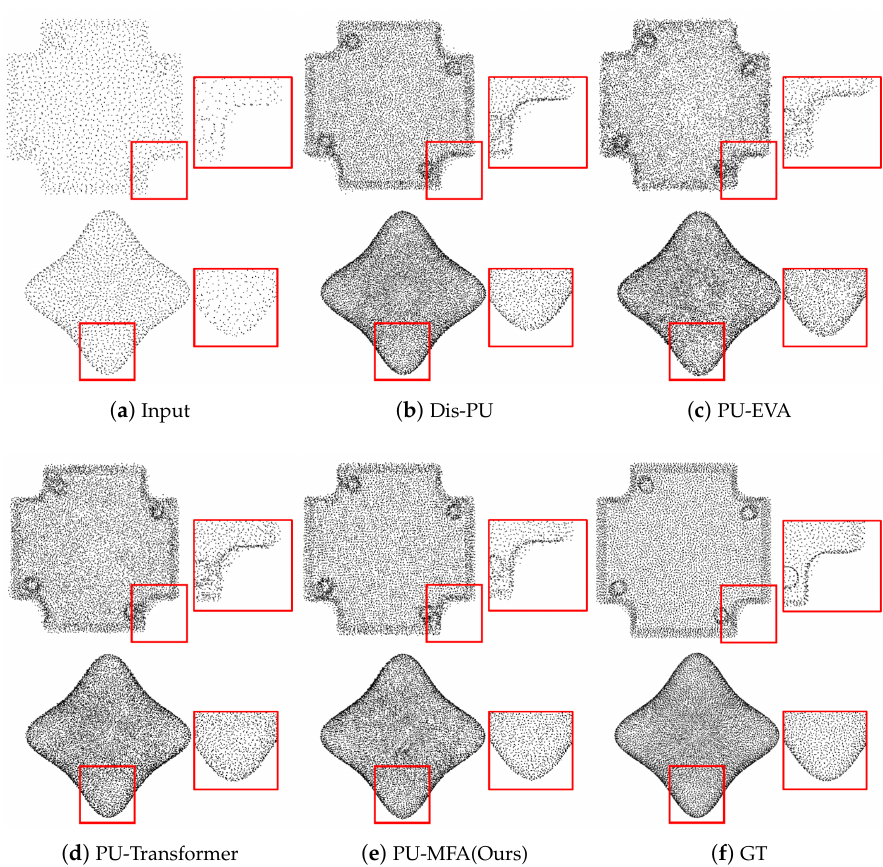
Figure 6. Visualization result of × 4 up-sampling on PU-GAN dataset (non-tubular objects).